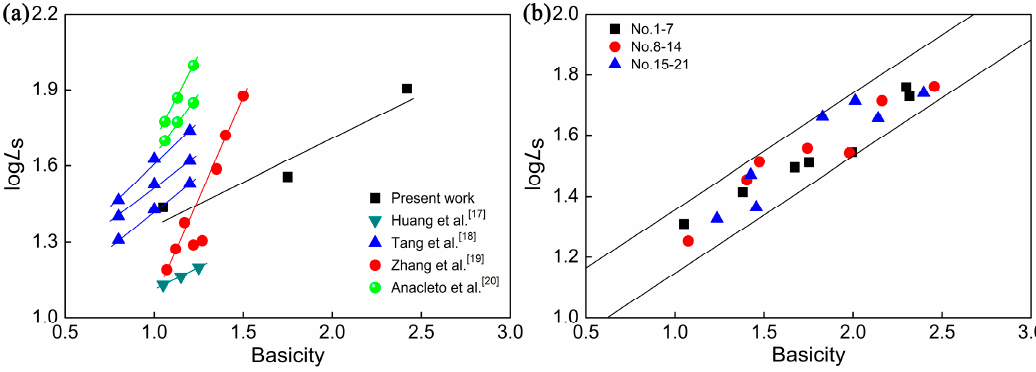
Figure 5. Effect of basicity on log L S .